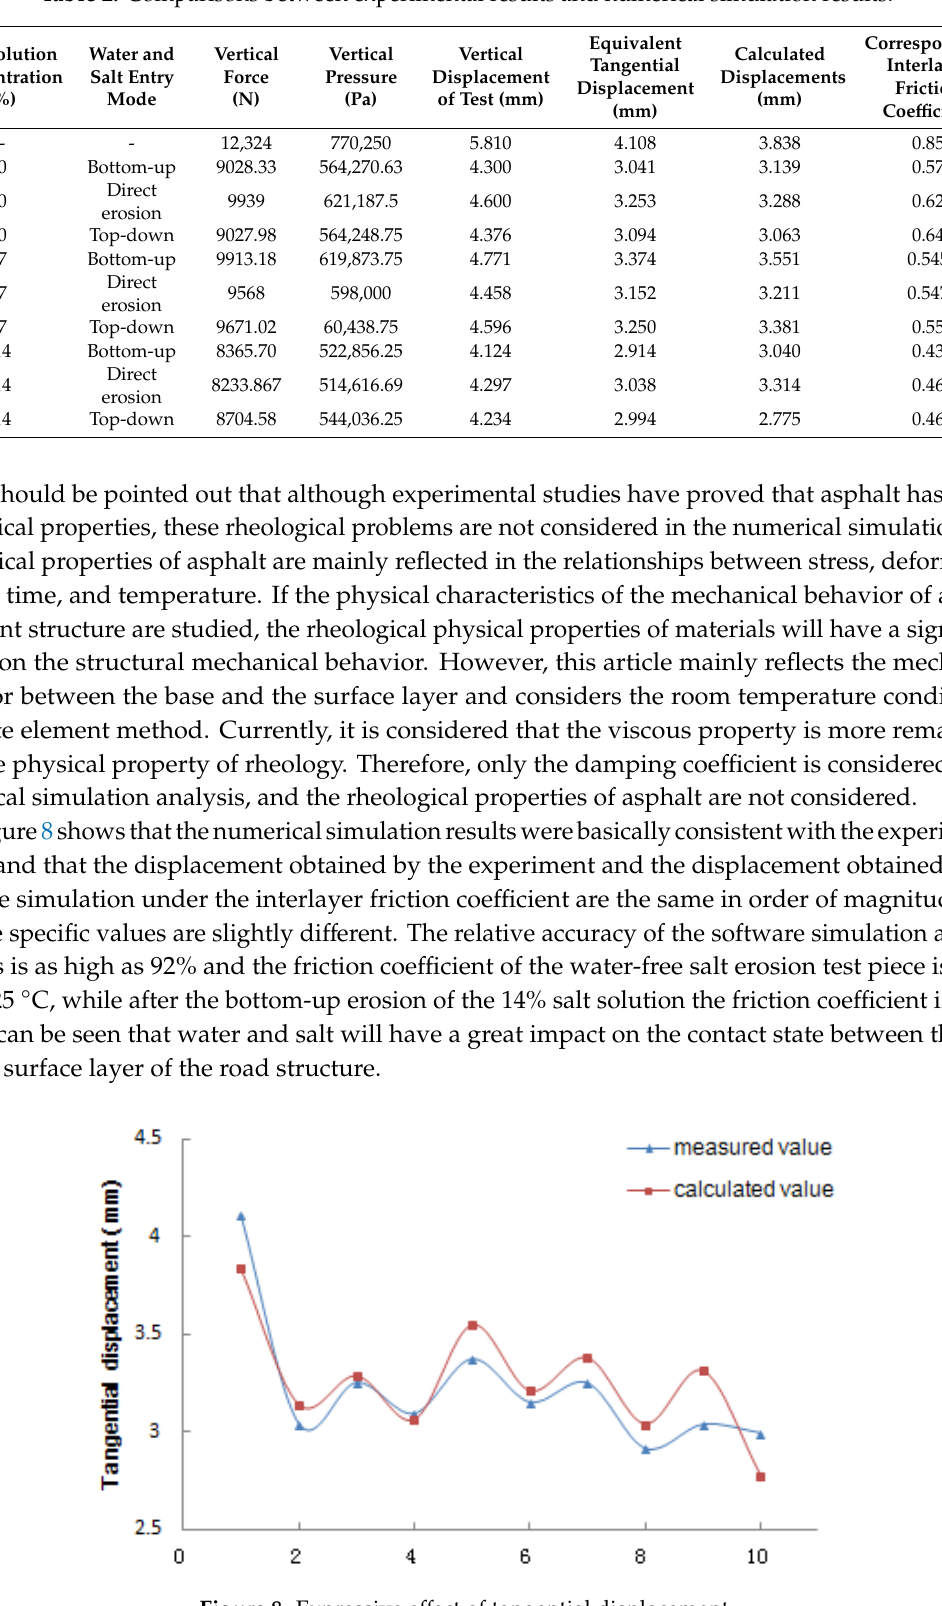
Figure 8. Expressive effect of tangential displacement.